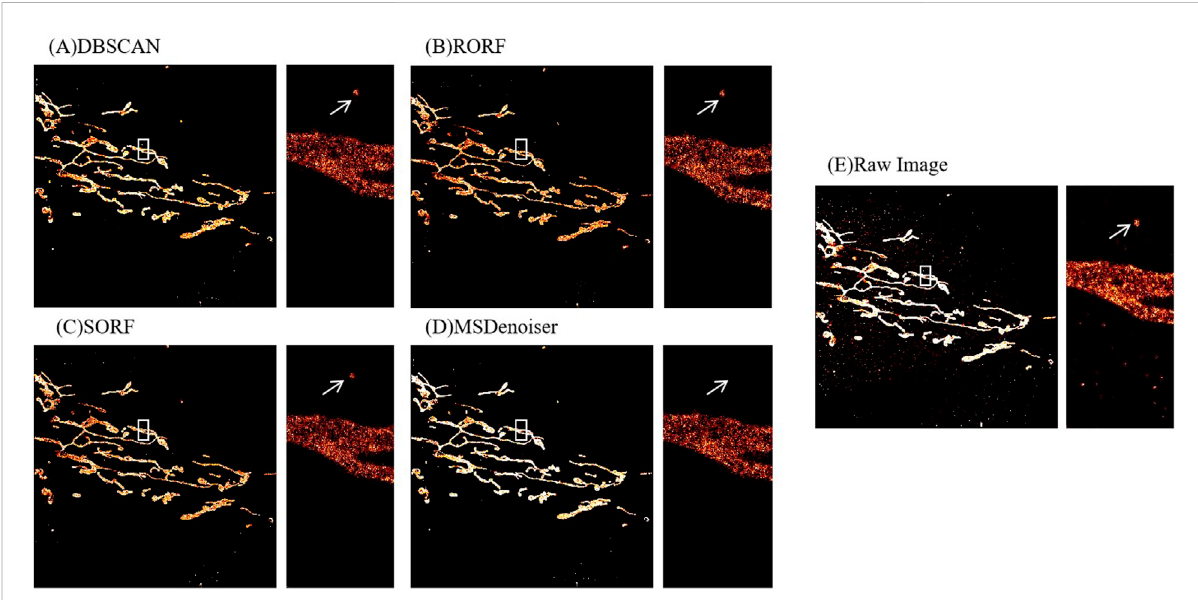
FIGURE 8 Comparison on the denoising performance of different methods using experimental mitochondrial protein data. (A) Denoised image from DBSCAN. (B) DenoisedimagefromRORF. (C) DenoisedimagefromSORF. (D) DenoisedimagefromMSDenoiser. (E) Rawrenderedimage.Thewhite arrows in (A – E) indicate nonspeci fi c clustering, the white arrow in (D) indicates the better denoising effect of MSDenoiser at the same